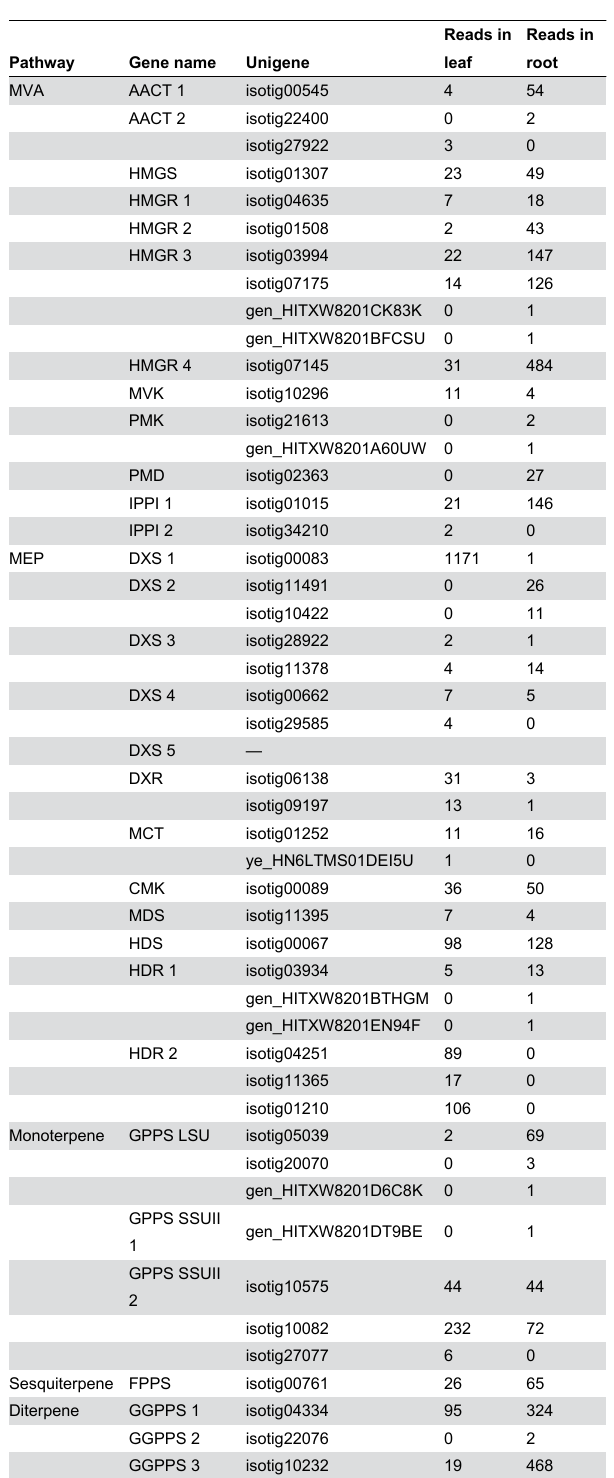
Table 2. Expression of unigenes in isoprenoid biosynthesis pathways.